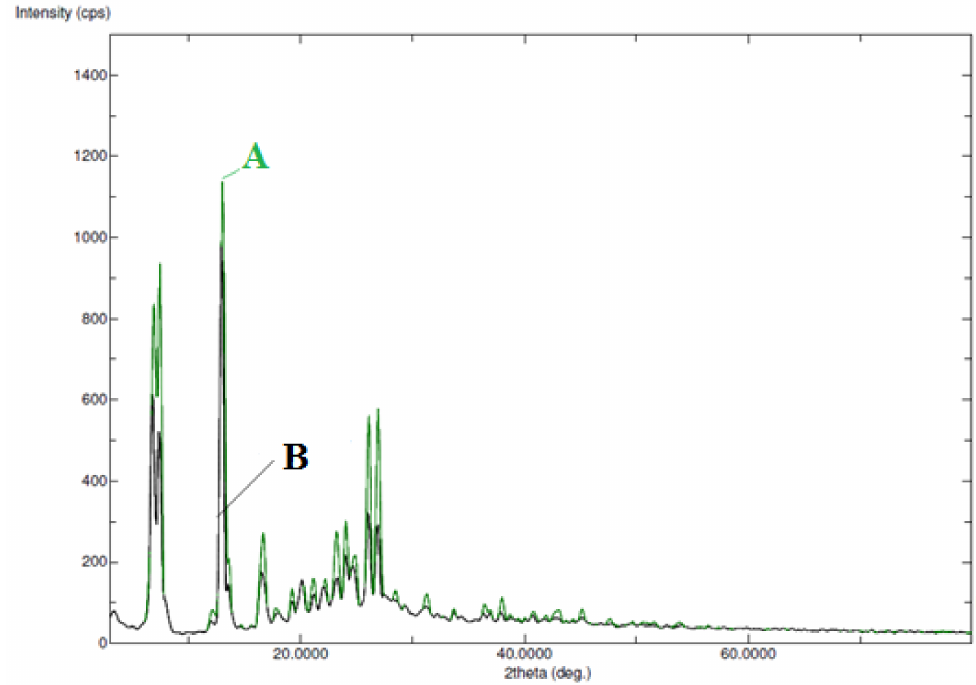
Figure 4. Powder X-ray diffraction (PXRD) spectra of ( A ) pure FBX and ( B ) equilibrated FBX recovered from